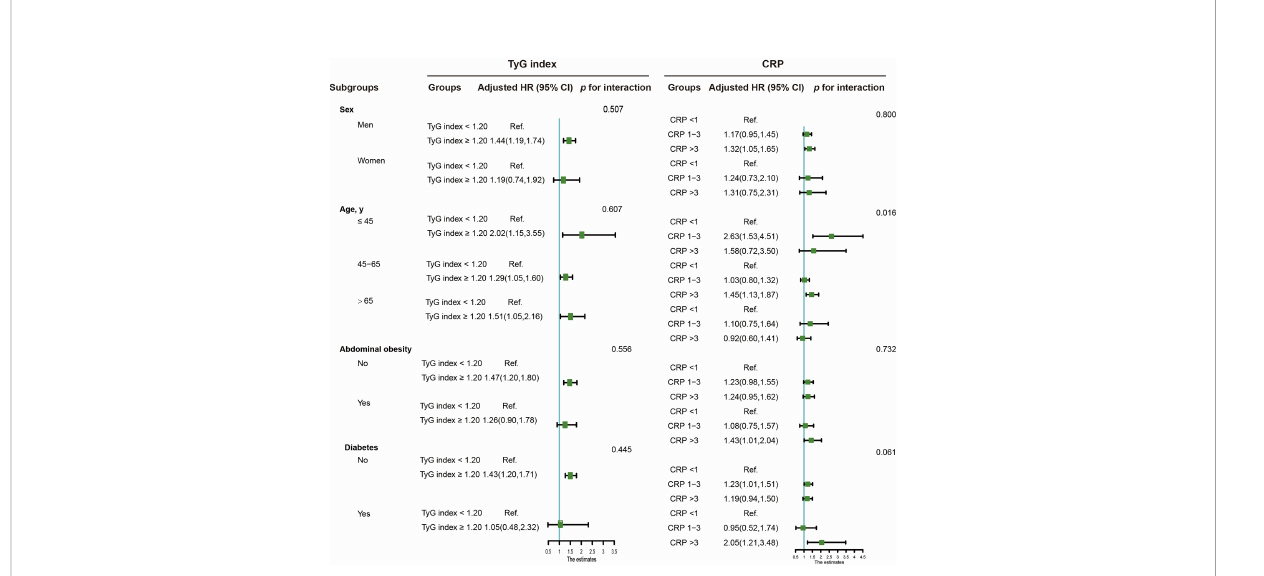
FIGURE 2 Subgroup analysis of the TyG index or CRP level association with CRC risk. Adjusted models were adjusted for age (every 10 years), sex, family income, educational background, marital status, WC, TC, smoking status, drinking status, physical activity, sedentary lifestyle, tea consumption, salt intake, high fat diet, hypertension, and family history of cancer.